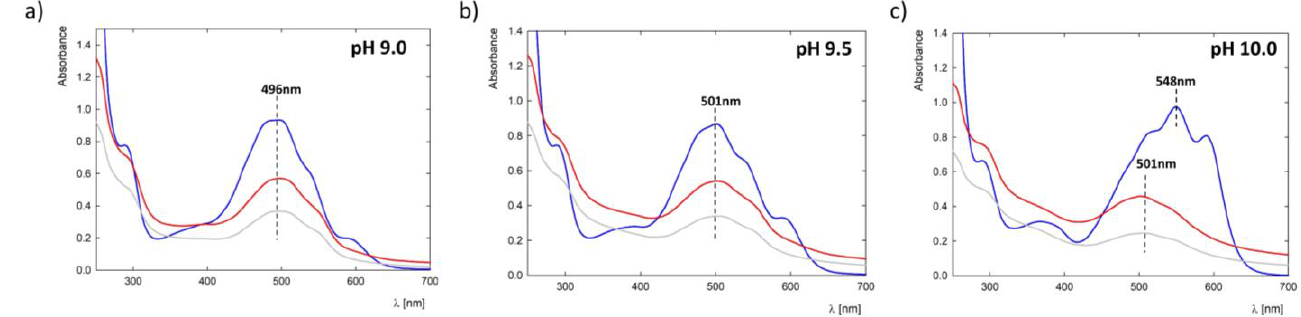
Figure 5. UV-Vis spectra of G4.0 PAMAM-DOX complexes with a molar ratio of 1:6 for selected pH values of the starting solution: ( a ) 9.0, ( b ) 9.5, and ( c ) 10.0 (blue line: starting complex, red: after 24 h of mixing, and gray: after dialysis).